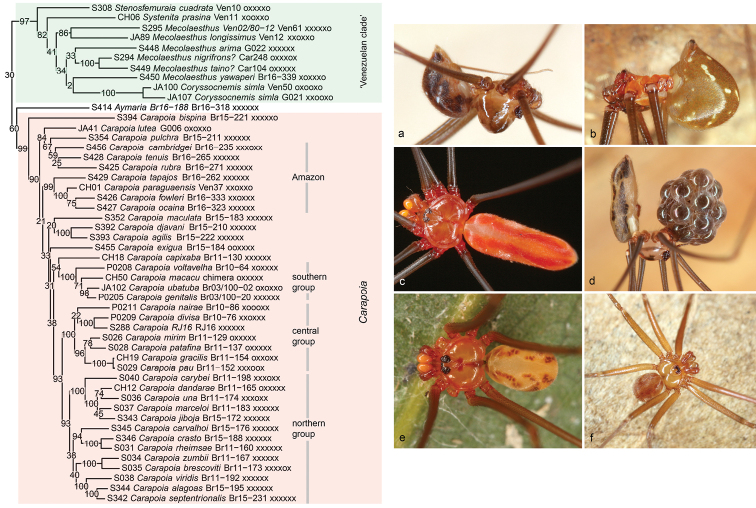
Venezuelan clade + Aymaria + CarapoiaaMecolaesthusyawaperi (Brazil) bAymaria sp. n. “Br16-188” (Brazil) cCarapoiarubra (Brazil) dCarapoiakaxinawa (Brazil) eCarapoiapulchra (Brazil) fCarapoiaagilis (Brazil).